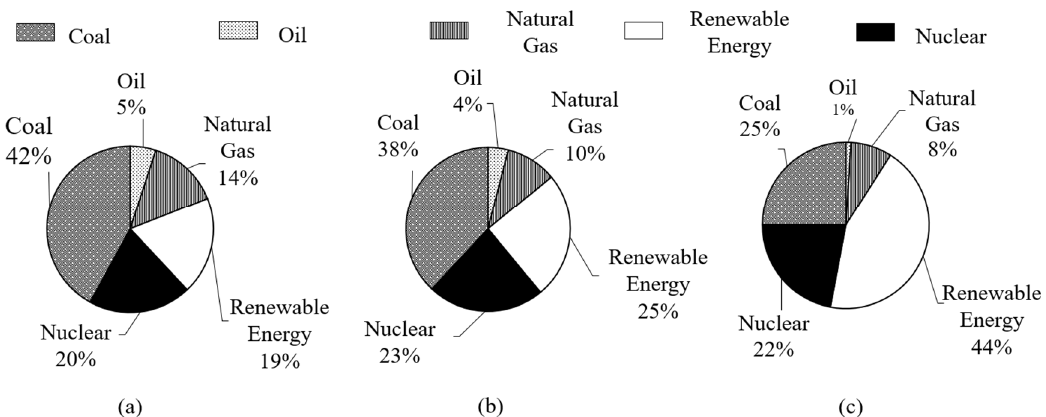
Figure 1. World primary electricity generation statistics chart ( a ) World primary energy for electricity generation 2010 ( b ) World primary energy for electricity generation 2017 ( c ) IEA Policy Statement 2040 [18].